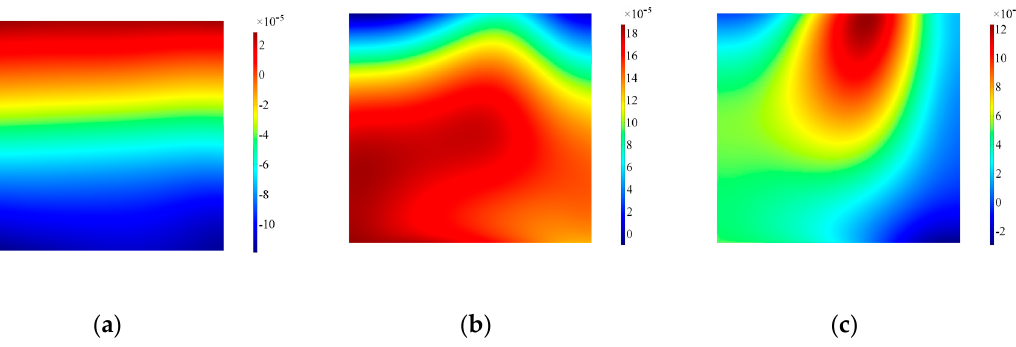
Figure 13. Surface plot for the in-plane velocity on the side of the backing mass, Configuration A. Note that data are plotted at timeframes of 100 μ s ( a ), 300 μ s ( b ) and 500 μ s ( c ).